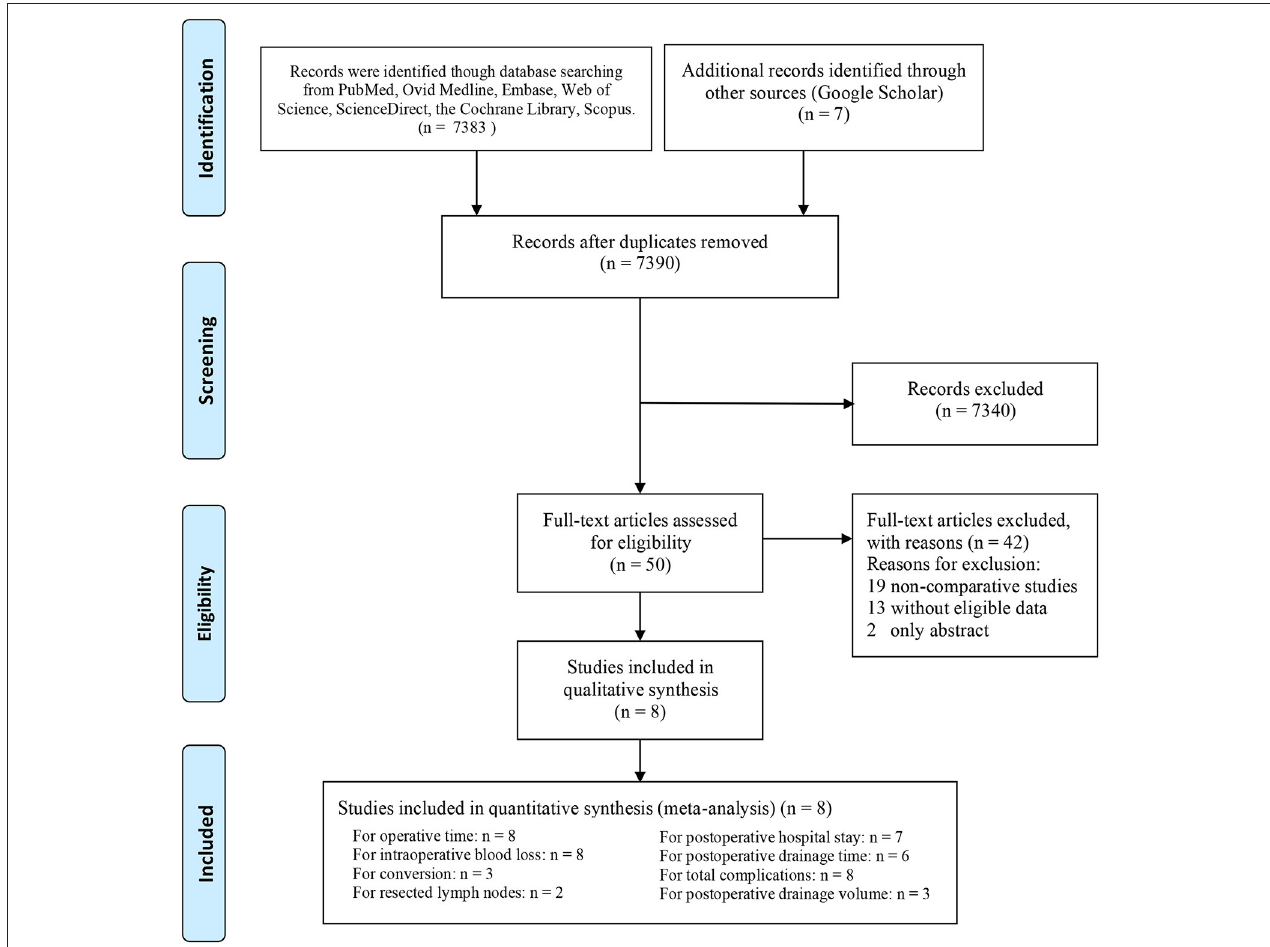
FIGURE 1 | Flow diagram of the research selection